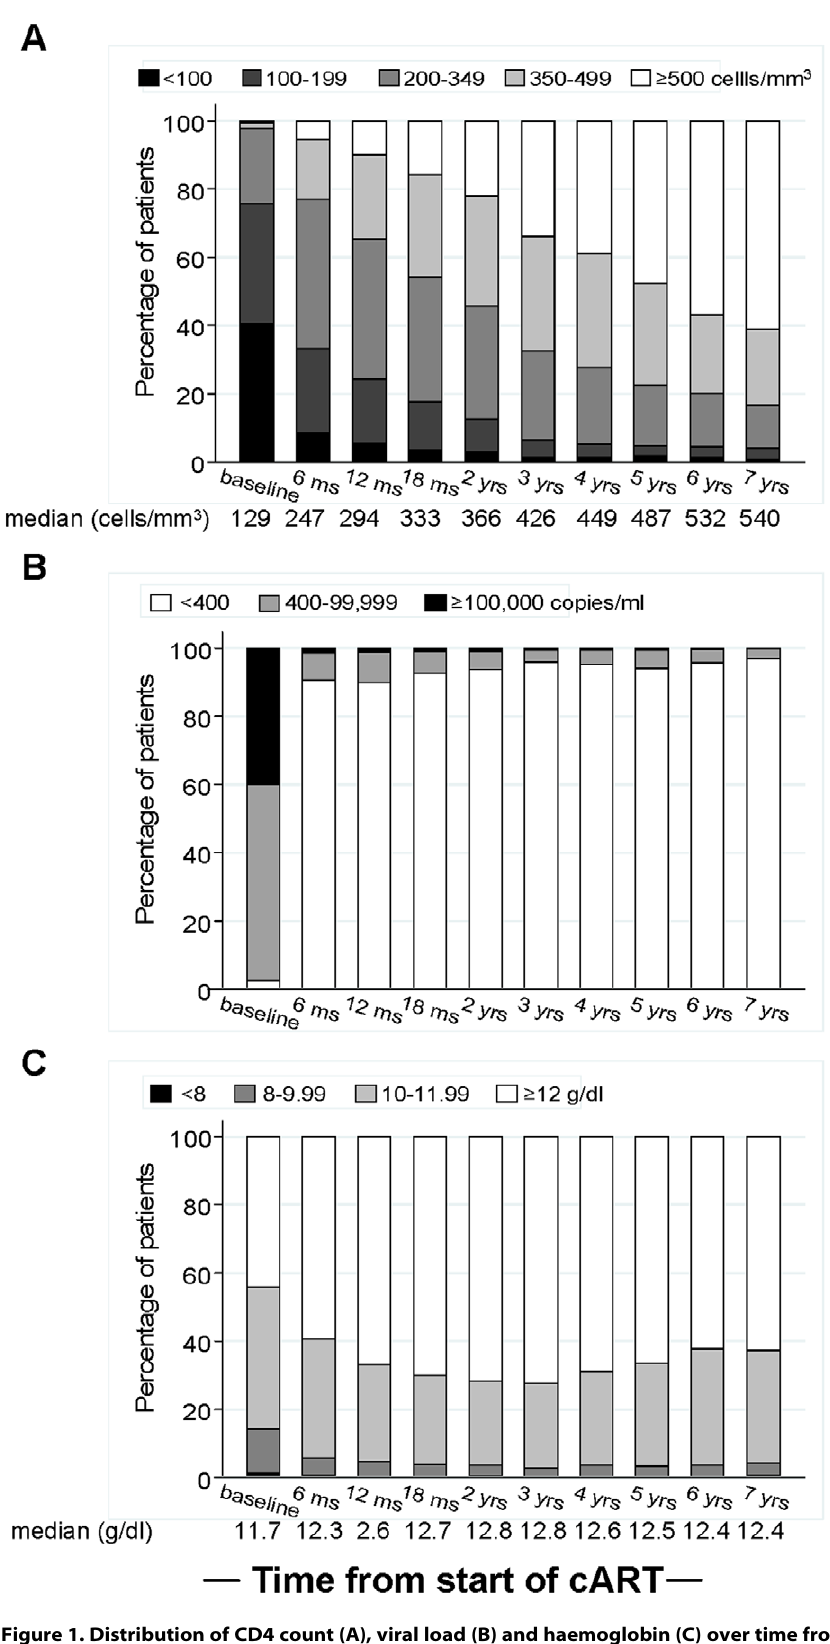
PLOS ONE | www.plosone.org